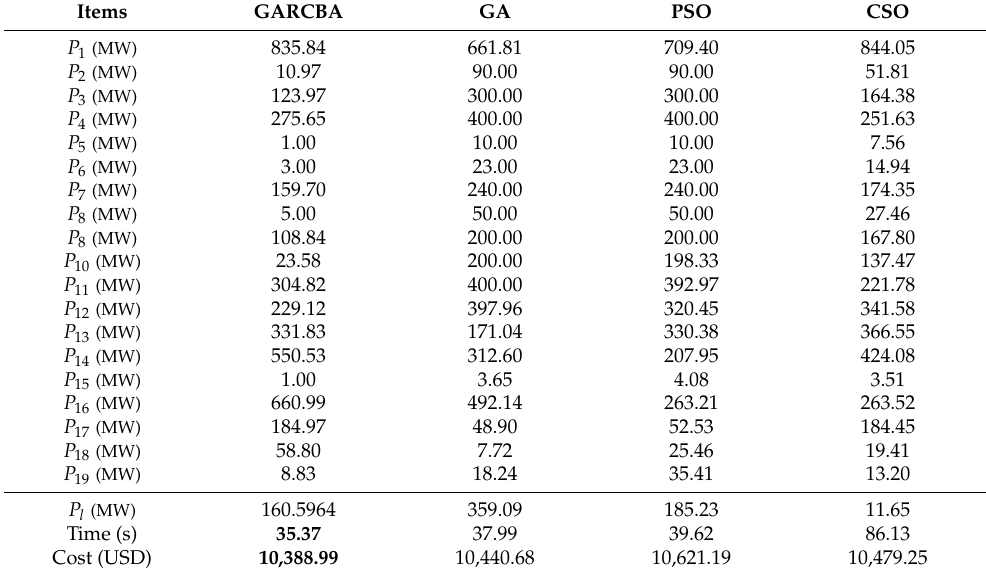
Table 5. Best cost solutions for Case 1.2 from 25 runs.